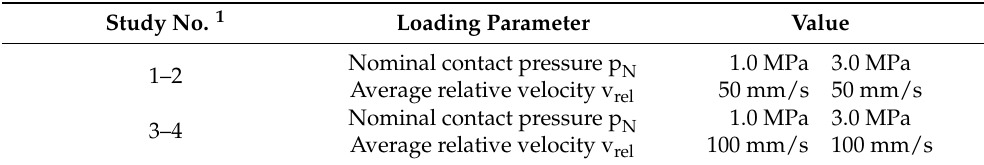
Table 3. Test matrix for tribological characterization of HPU premium.